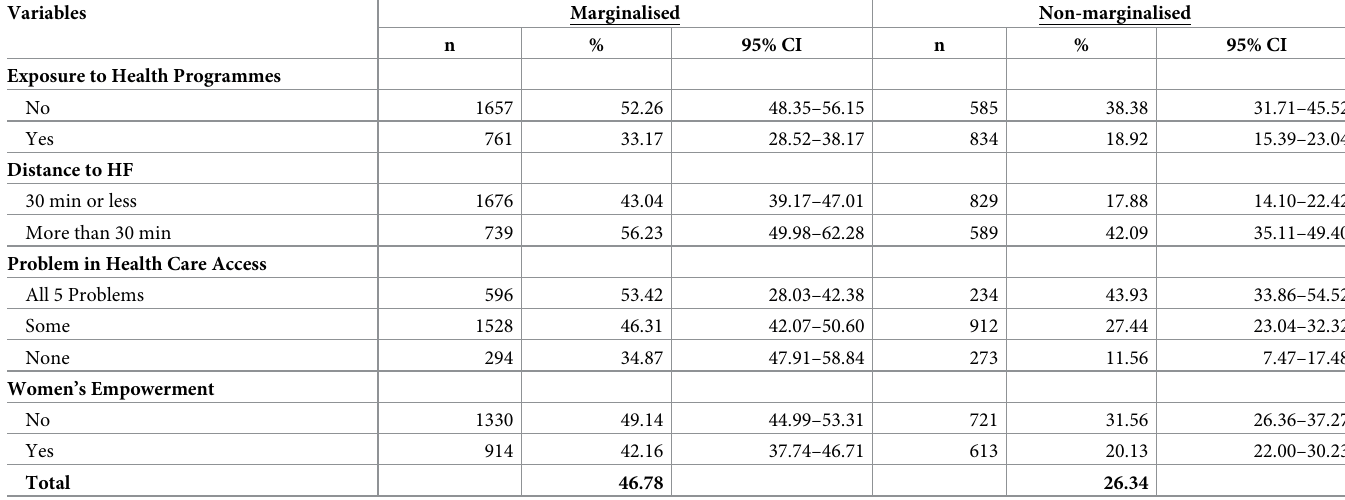
Table 4. Percentage of marginalised and non- marginalised women delivering their last child at home, according to access to health care and women empowerment. Variables